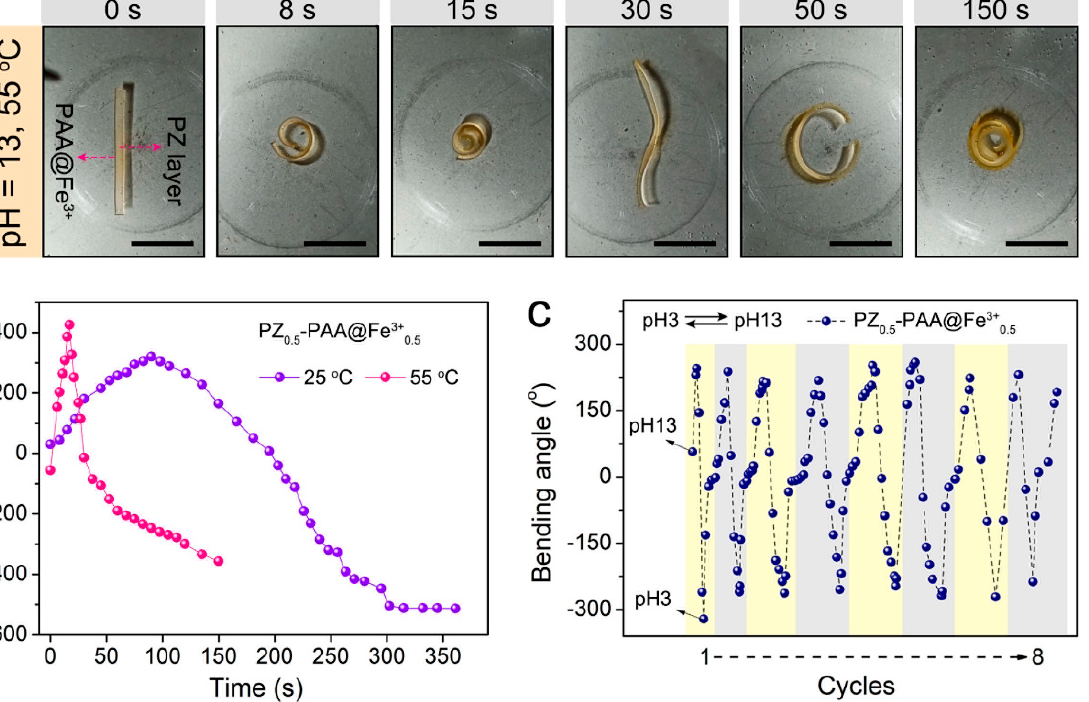
Figure 4. ( a ) Optical photos of bending process of PZ-PAA@Fe 3+ bi-layer hydrogel strip in pH = 13 at 55 °C. ( b ) Bending kinetics of bi-layer hydrogel strips affected by temperature. ( c ) Reversible bending behavior of the bi-layer hydrogel between pH = 3 and pH = 13. All scale bars are 10 mm.